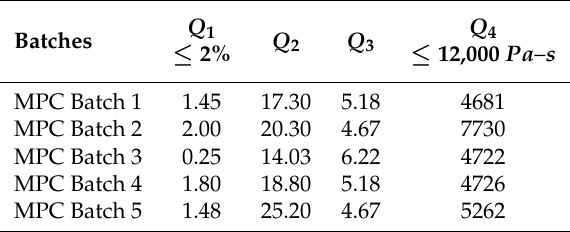
Table 3. Zero-blend constrained